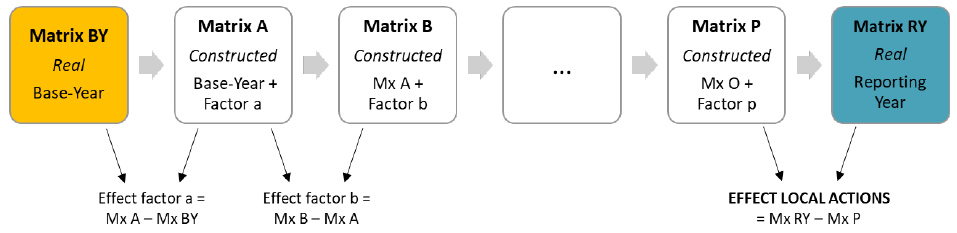
Figure 1. Schematic representation of the decomposition analysis (based on [14]).